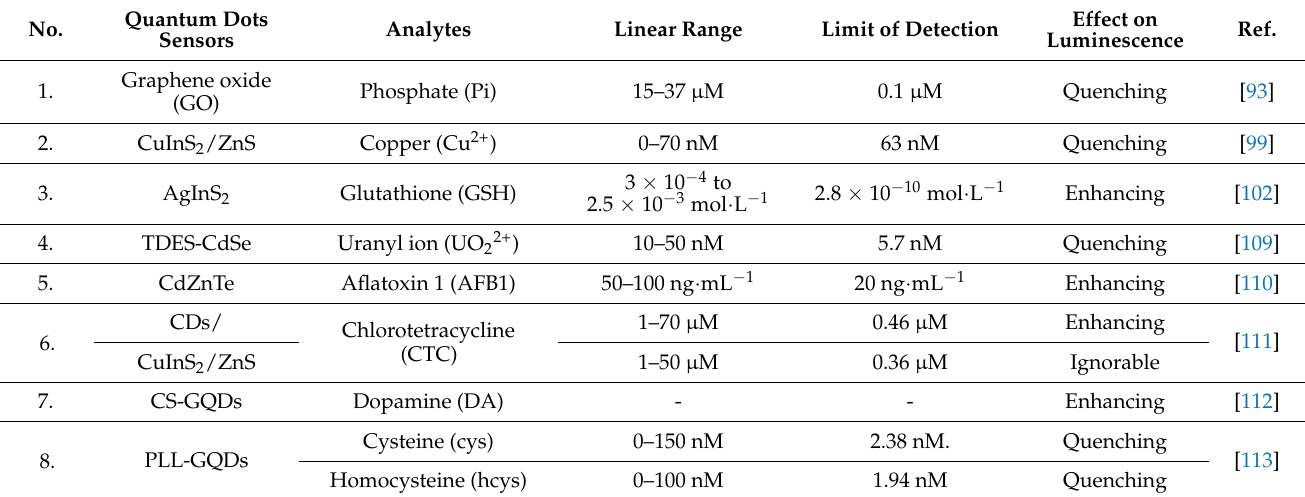
Table 2. Summary of quantum dots used for the detection of harmful